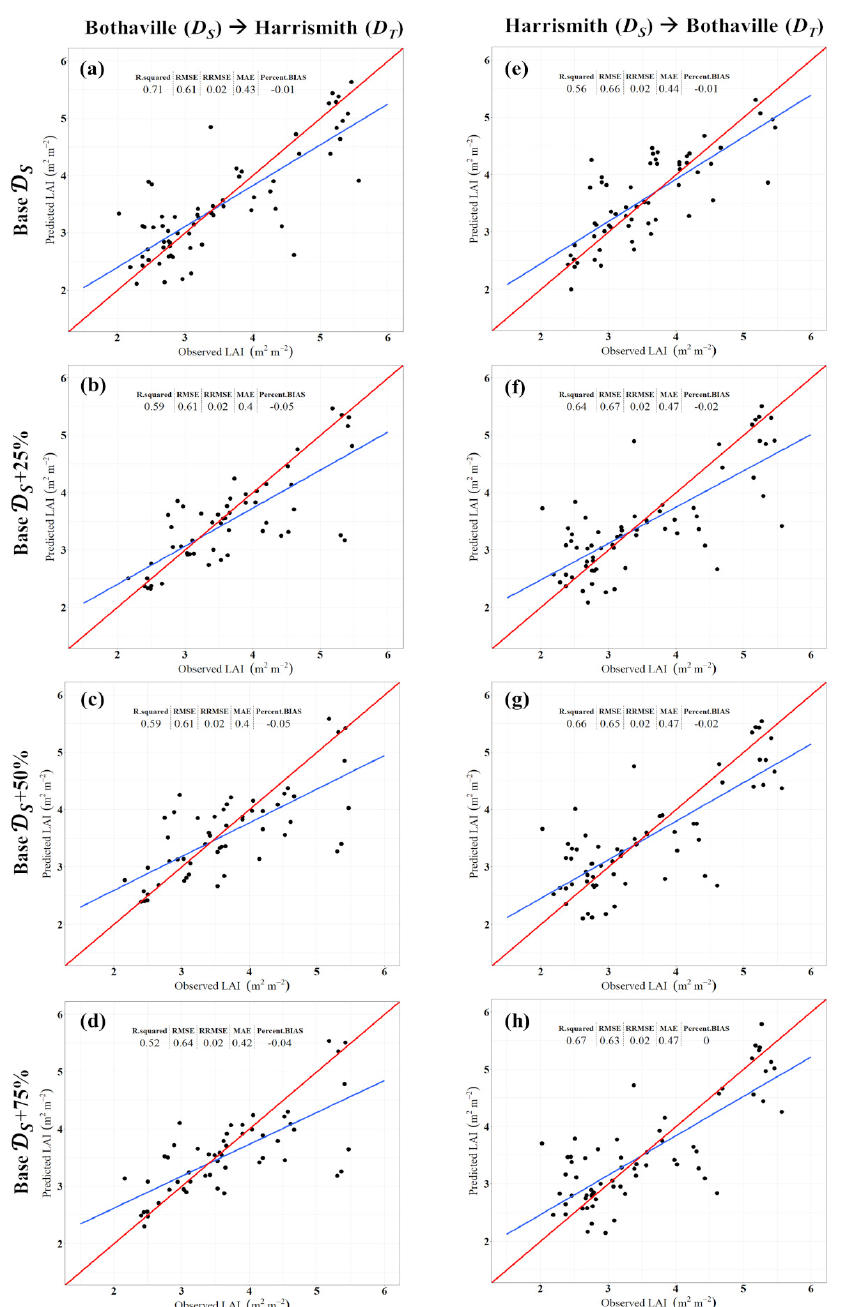
Figure 3. Scatterplots for Leaf Area Index (LAI, m 2 m − 2 ) indicating the performance of the XGBoost models in the Source D S and Target D T sites considering scenarios where only 25% (Base D S + 25%, ( b , f )), 50% (Base D S + 50%, ( c , g )), and 75% (Base D S + 75%, ( d , h )) of the training data are available in the Target D T site. Base D S models for cases where Bothaville and Harrismith are the Source sites D S are shown in panels ( a , e ), respectively. The 1:1 and the regression lines between the observed and predicted values are shown in red and blue,